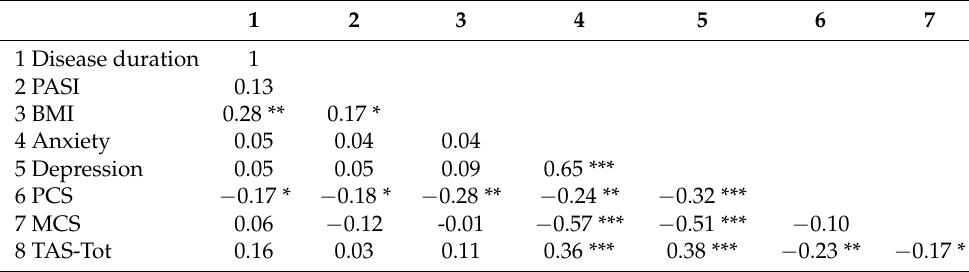
Table 2. Relationships between variables in the whole sample.